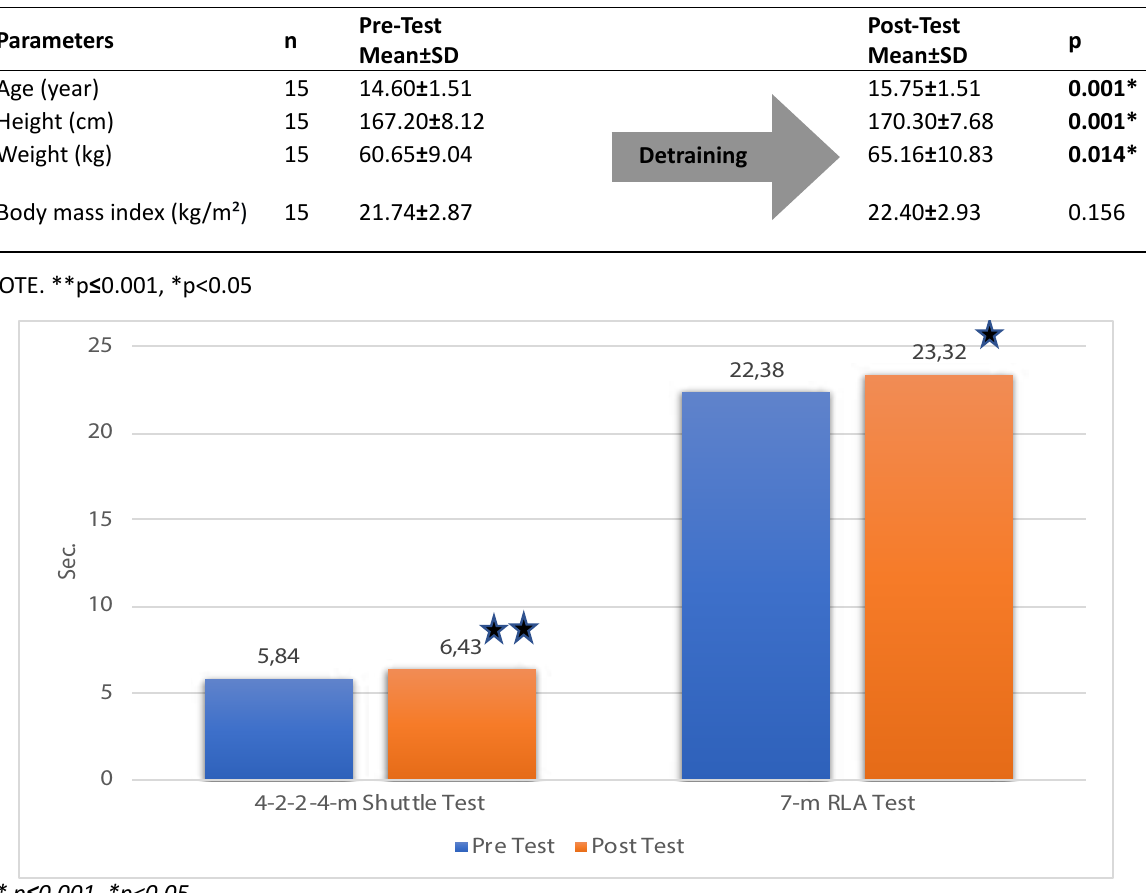
Figure 3. 4-2-2-4-m and 7-m RLA test results